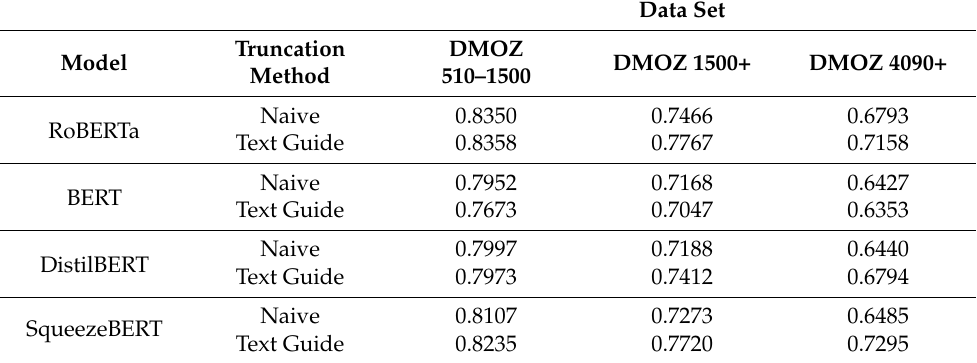
Table 6. Experiments performed with selected pre-trained transformer models. Text Guide parame- ters were adopted (1) from the optimization procedure for the AlBERT model from the original Text Guide study and (2) according to suggestions regarding other parameter values, as presented in this